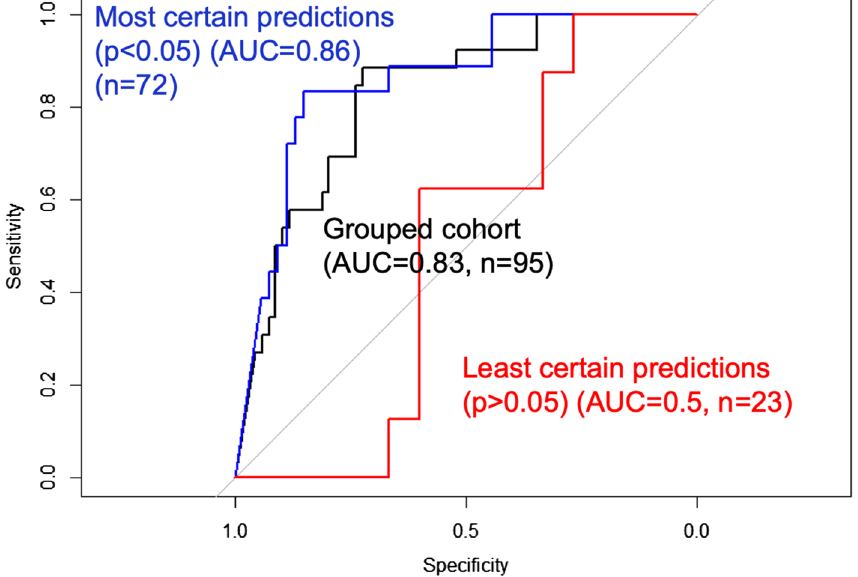
Figure 3. Model performance increases with lower predictive uncertainty. Shown are the area-under-the- curve (AUC) measures for receiver operator characteristics (ROC) analysis of sample predictions stratified by predictive uncertainty. The sample predictions with lowest uncertainty (p < 0.05) (blue curve, n = 72) achieved the highest performance (AUC = 0.86) compared to the entire grouped cohort irrespective of uncertainty (AUC = 0.83) (black curve, n = 95). Meanwhile, the sample predictions with greatest uncertainty (i.e., least certain predictions) showed the lowest classification accuracy (AUC = 0.5) (red curve, n = 23).